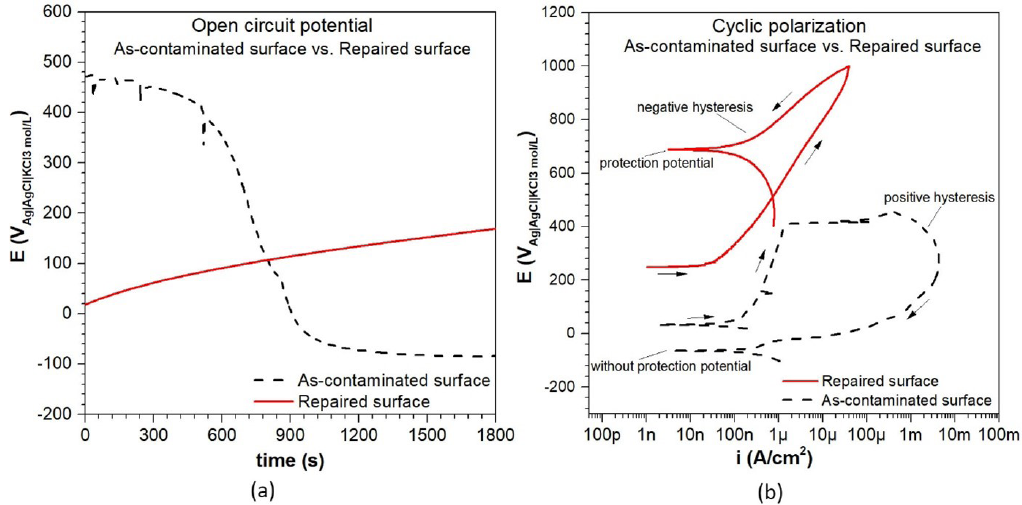
Figure 4. On-site electrochemical measurements to the AISI 316L aseptic tank comparing the surface conditions inspected: as-contaminated and repaired surfaces. It is showed in (a) open circuit potential curves and (b) cyclic polarization curves obtained at 2.0 mV/s. Electrolyte: 3.5% NaCl and 25 o